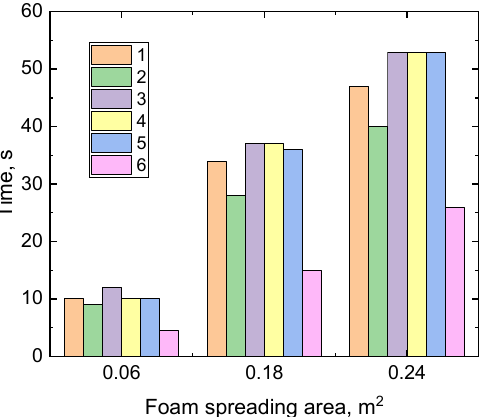
Figure 10. Change in spreading foam area according to time [64].